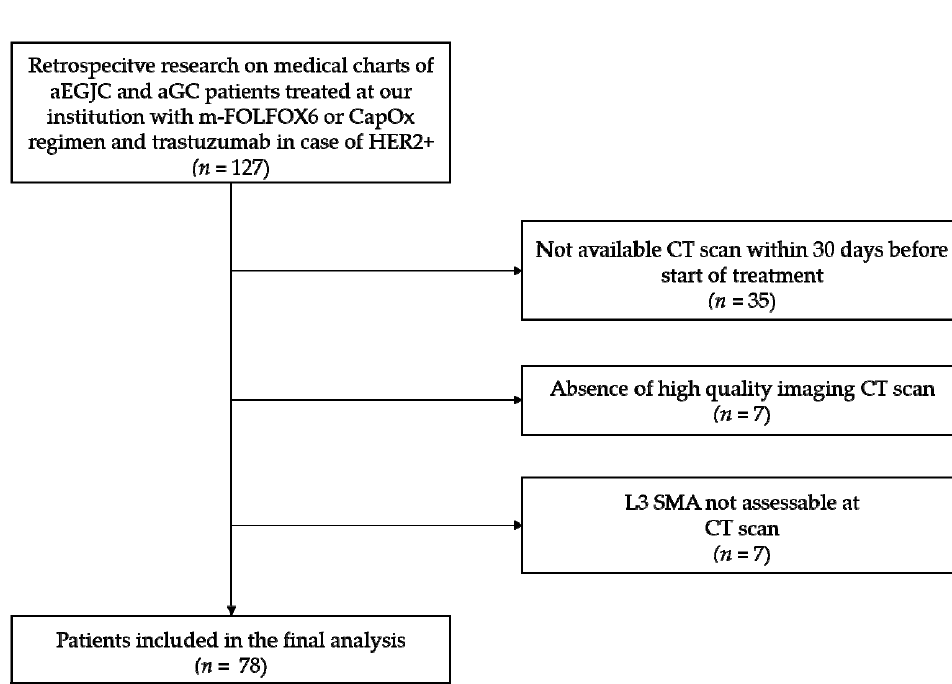
Figure A1. Patient’s selection flow-chart. Abbreviations: aEGJC, advanced oesophagogastric junction cancer; aGC, advanced gastric cancer; HER2, epidermal growth factor receptor 2; CT, computed tomography; L3 SMA, third lumbar vertebra skeletal muscle area.